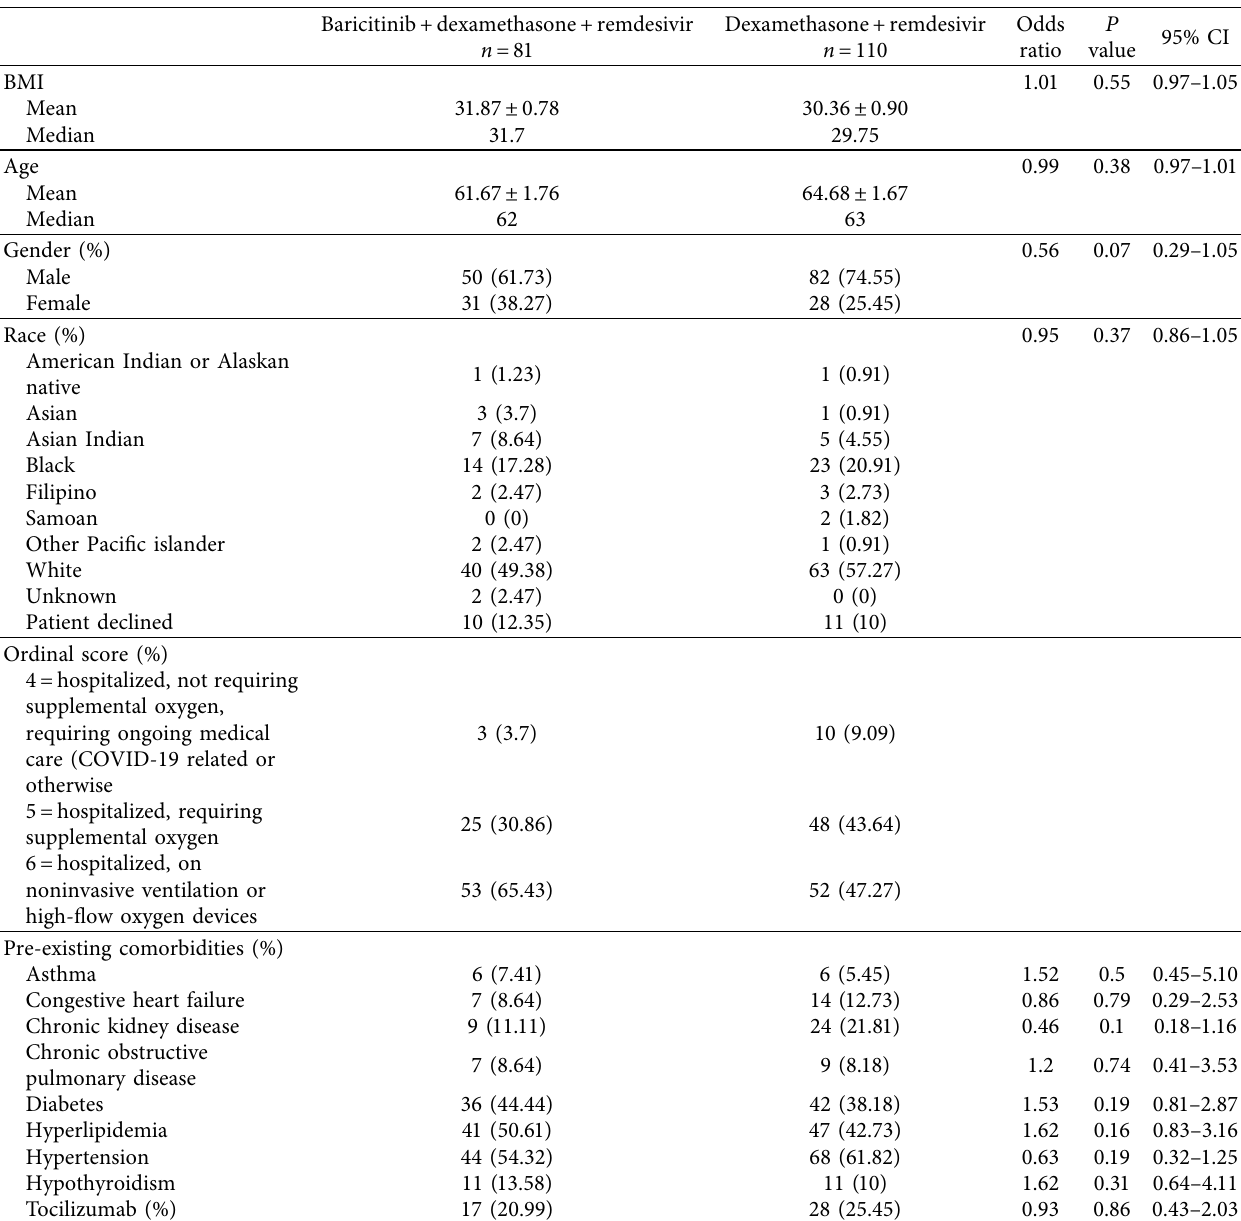
Table 1: Baseline demographic and clinical